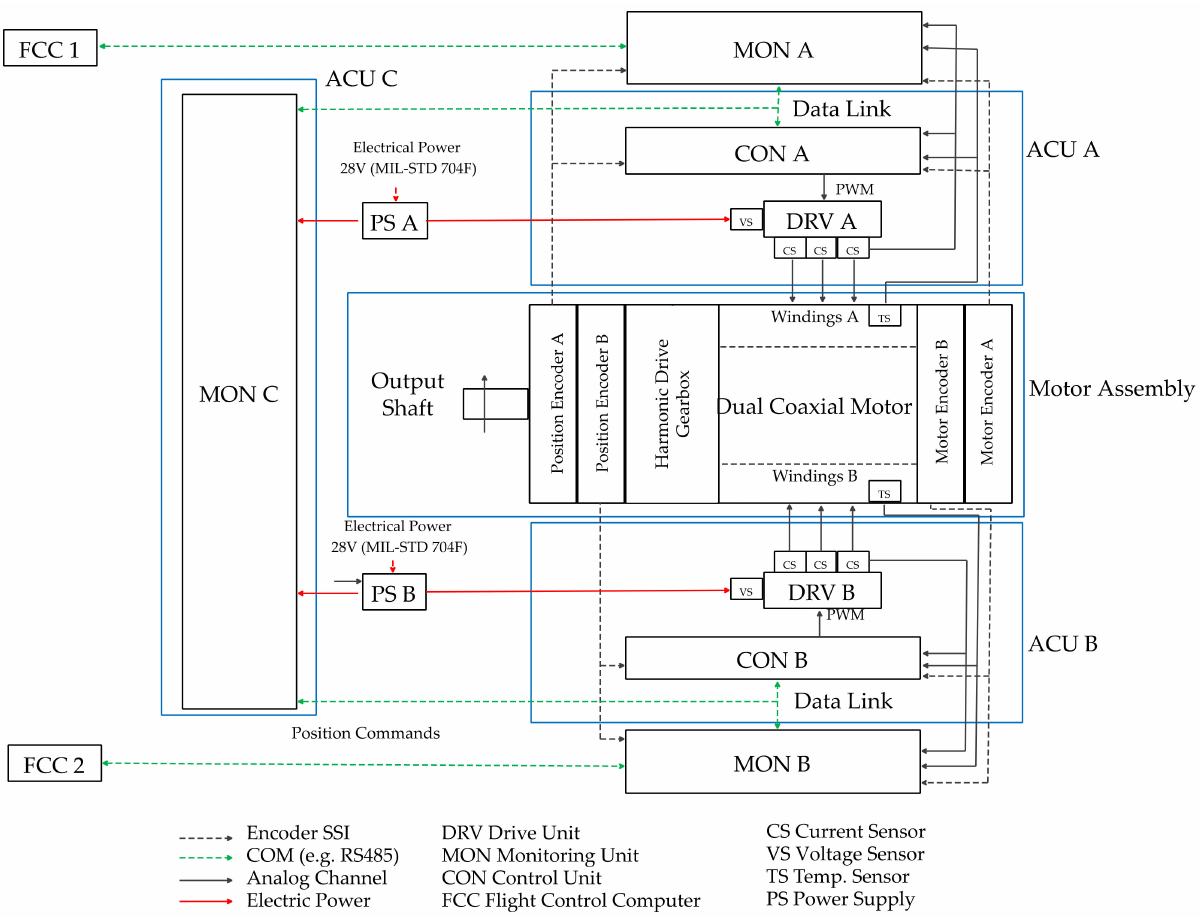
Figure 1. Overall actuation architecture containing two fault-tolerant motor channels as well as a single mechanical path.